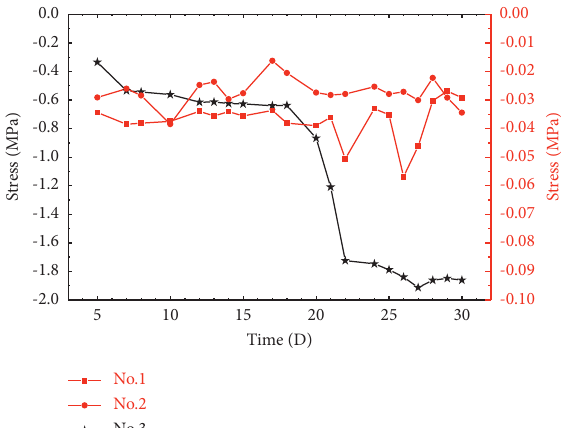
Figure 7: Variations of interaction stress between the horizontal shaft lining and the surrounding rock at the − 1117.7m shaft